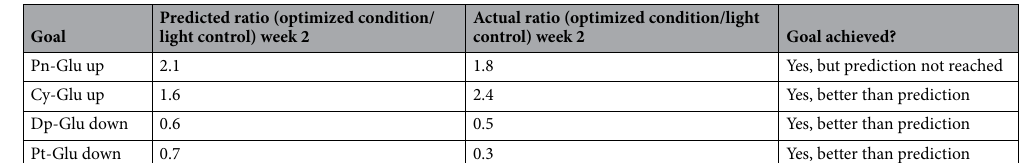
Table 6. Predicted and actual ratios between the anthocyanin concentrations of cells cultivated under different lighting conditions. Predicted ratios were calculated the following before conducting the control experiment: the anthocyanin concentration in week 2 in cells cultivated under the optimized lighting conditions were predicted using the numerical optimization tool of the Design-Expert software and then divided by the actual anthocyanin concentration in cells cultivated under white light in week 2 of the main experiment. Actual ratios were calculated after analyzing the control experiment: the actual anthocyanin concentration in cells cultivated under optimized lighting conditions in week 2 of the control experiment was divided by the actual anthocyanin concentration in cells cultivated under white light in week 2 of the control experiment. Conc. = Concentration, Cy = Cyanidin, Dp = Delphinidin, Pn = Peonidin, Pt = Petunidin, Glu = Glucoside, Up = Upregulation (the goal is to maximize the concentration), Down = Downregulation (the goal is to minimize the